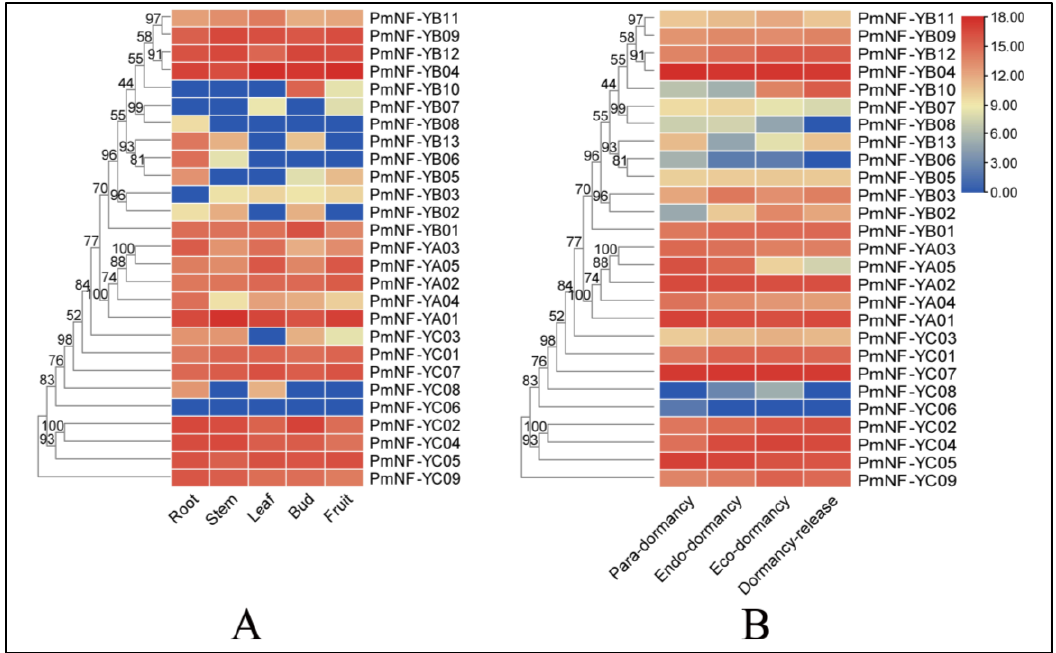
Figure 8. Expression levels of PmNF-Y genes in different tissues and at different stages of dormancy: ( A ) expression profiles of NF-Y genes in five different tissues; ( B ) expression profile of NF-Y genes in the four different dormancy stages.